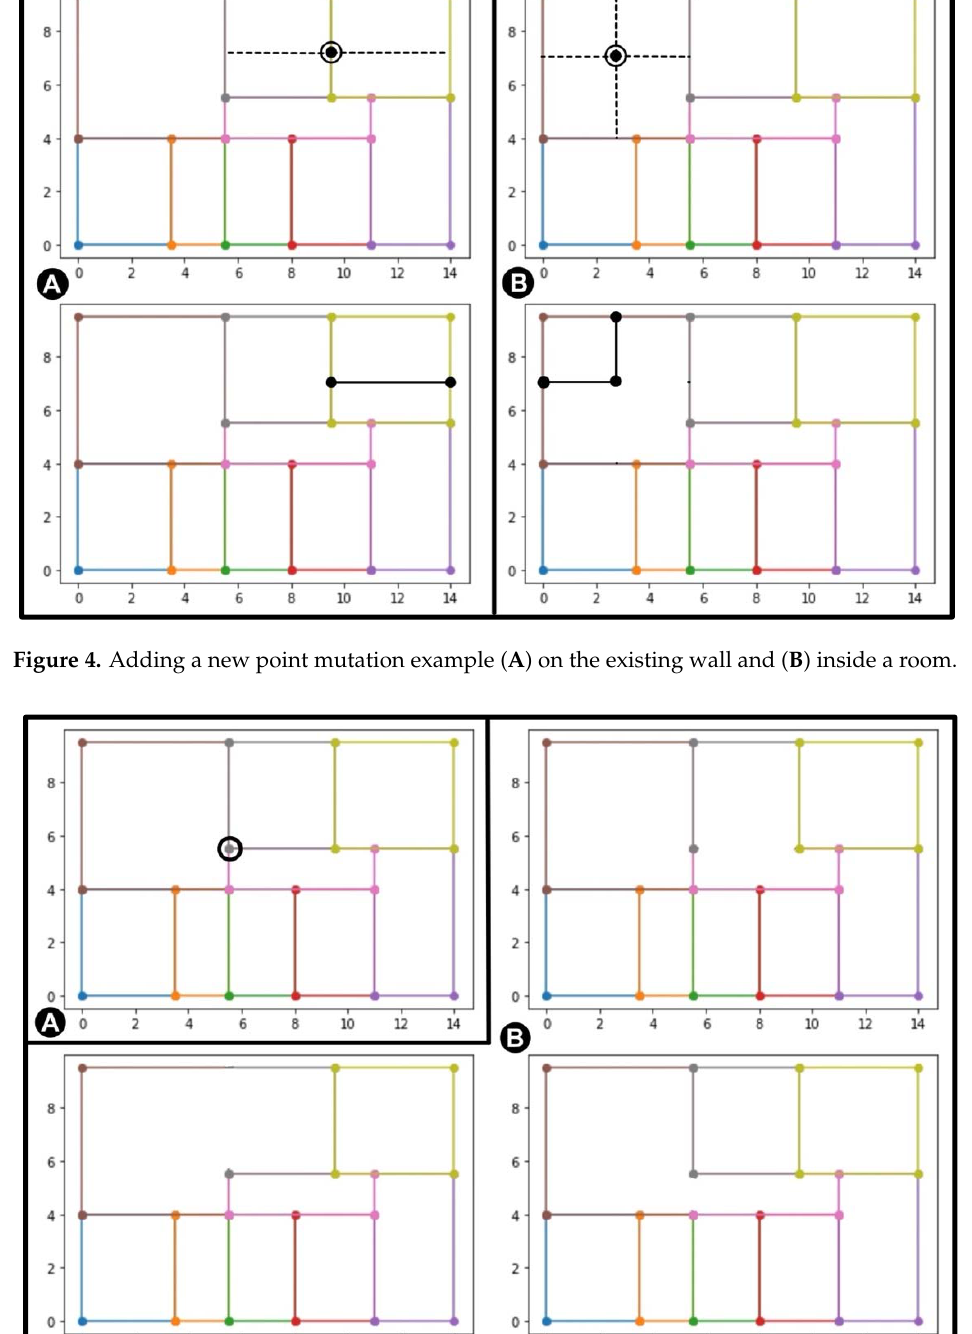
Figure 6. Moving a point mutation. (A) Selected point. (B) Three possible realizations. Selection: The selection operator is applied to choose the individuals that survive to the next generation. In EP, both parents and their offspring compete to survive, and this competition is based on the relative fitness value. The relative fitness may be simply cal- culated as the number of competitors that are less adapted and have lower fitness function evaluations. It expresses how well an individual performs in a group, and based on that score, any of a number of selection operators that have been developed can be used: ran- dom, proportional, tournament, rank-based, elitism, hall of fame, etc. Since the goal of our approach was to preserve the high diversity in the population, a roulette wheel